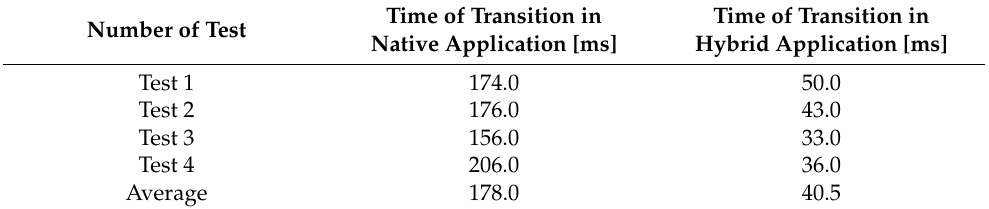
Table 3. Time taken to transition between the user profile and login